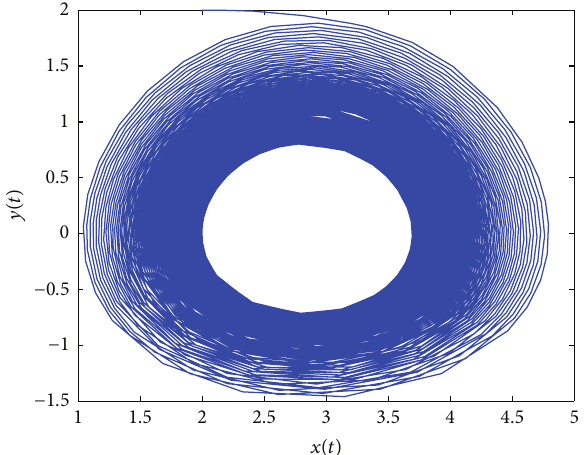
Figure8: 𝜏 1 = 0.2046 , 𝜏 2 = 0.68 , (𝑝 ∗ ,0) ,periodicsolutionbifurcates from (𝑝 ∗ , 0)